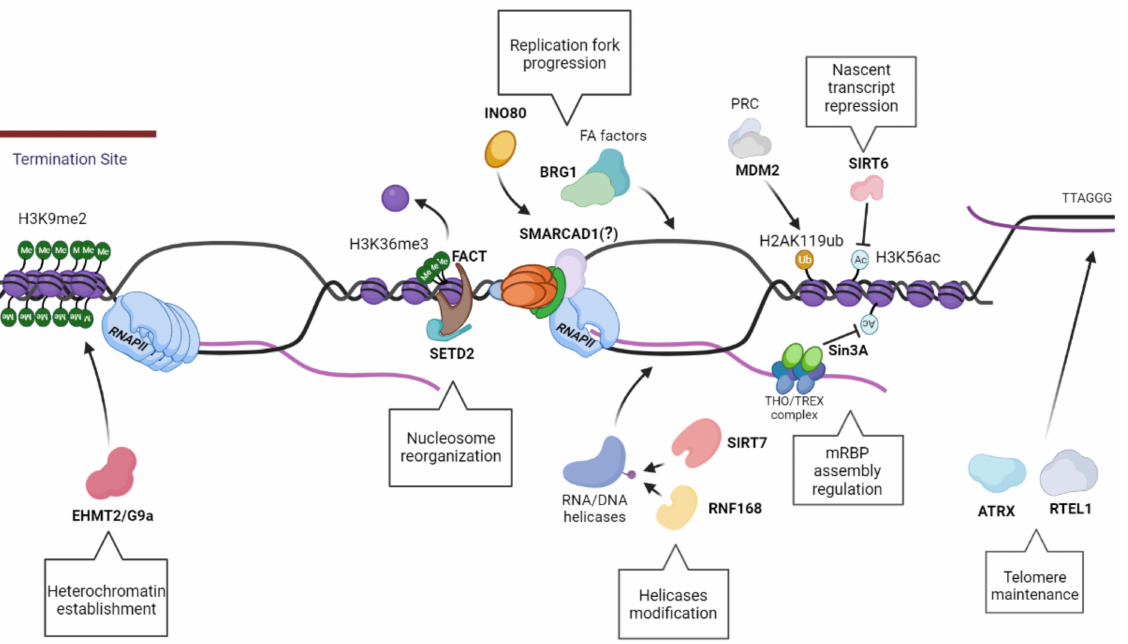
Figure 4. Schematics showing multiple distinct pathways of R-loop resolution mediated by the Chro-Mates, the chro- matin modifying and remodeling factors, described in Sections 8 and 9. EHMT2/G9a regulates the preservation of the heterochromatin, especially at the termination sites, in order to permit a successful transcription termination. In